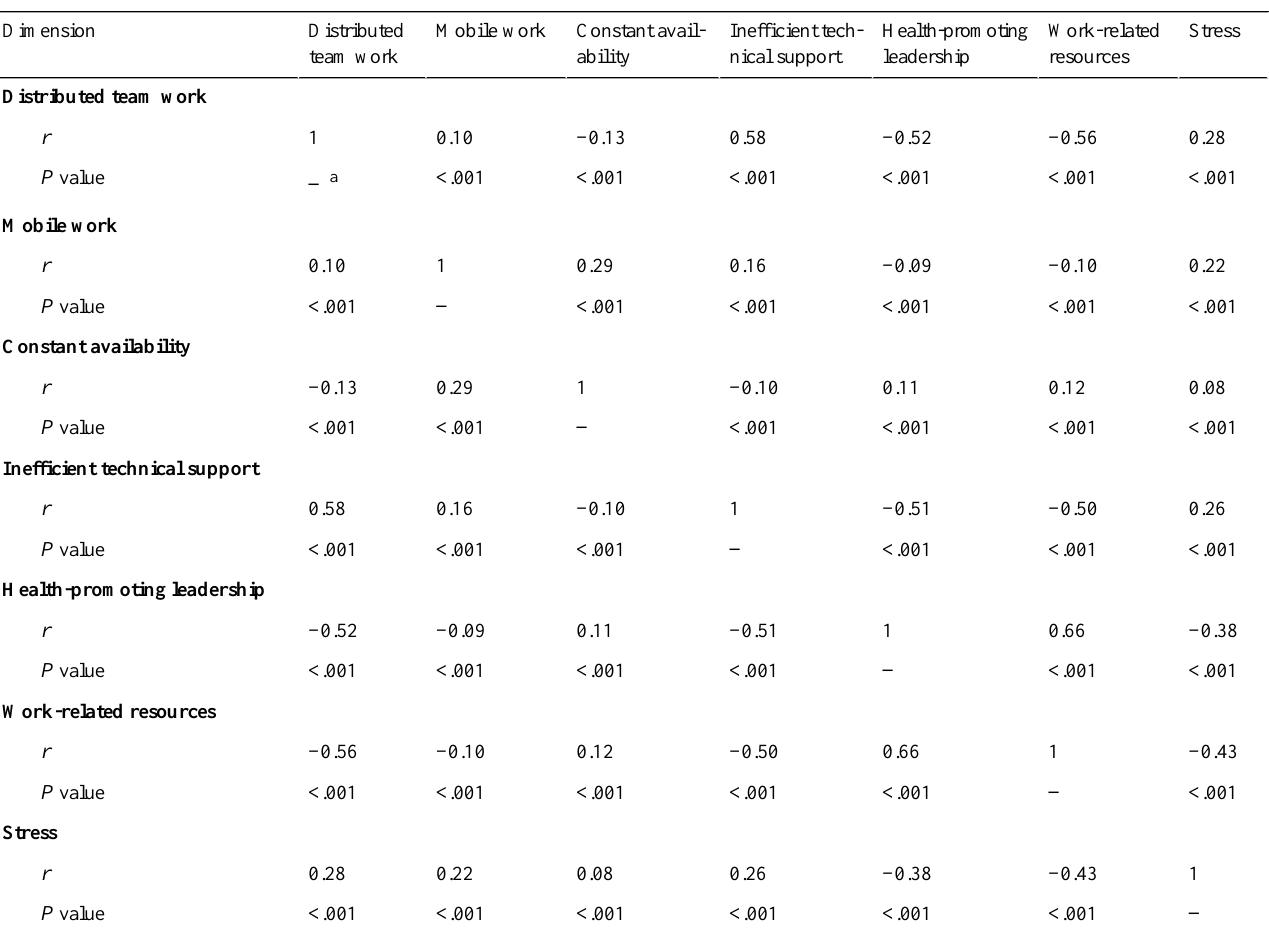
Table 3. Correlations between all study variables